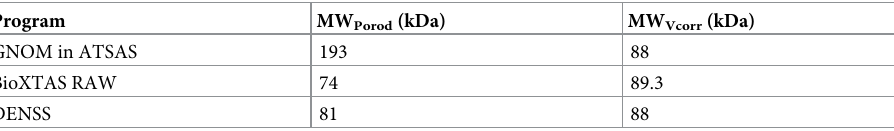
Table 1. FopA MW estimation from SAXS